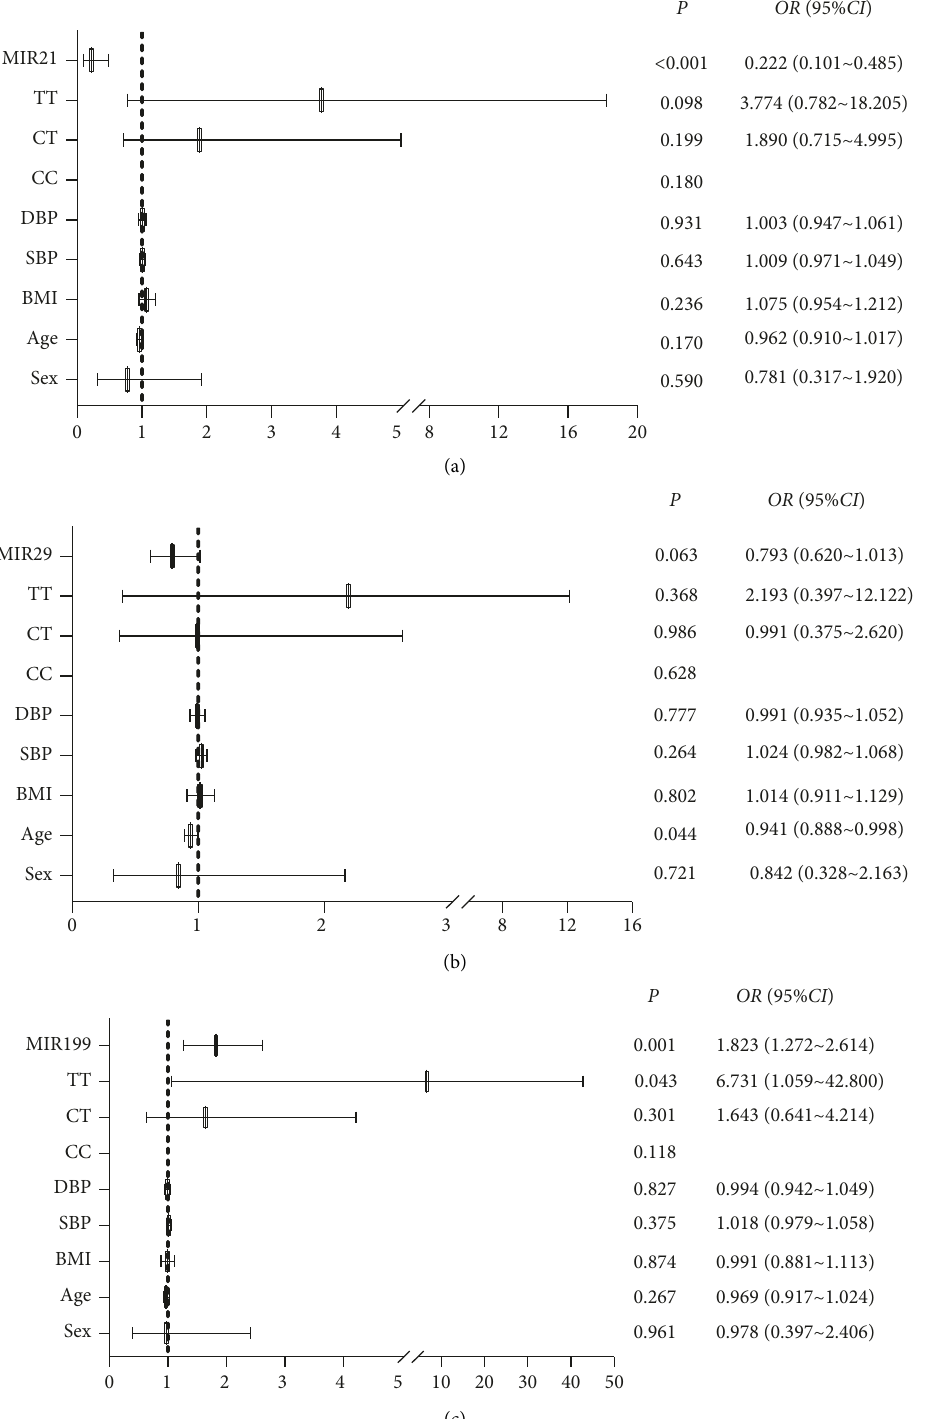
Figure 2: Forest plots of multivariate logistic regression analysis of the association between HCY patients and miR-21, miR-29, and miR-199 expression levels. The logistic regression analysis respectively adjusted sex, age, BMI, systolic blood pressure, diastolic blood pressure, and MTHFR C677T gene polymorphism. P < 0 . 05 or P < 0 . 001 was considered as